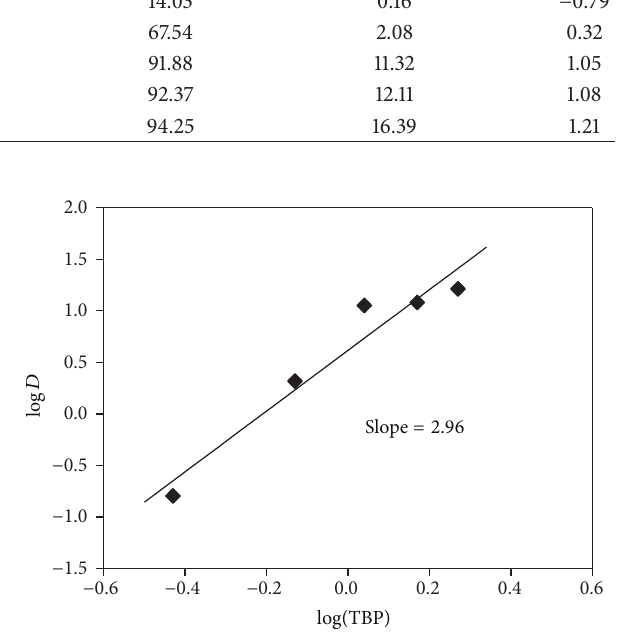
Figure 2: Effect of contact time on Te(IV) extraction. Figure 3: log